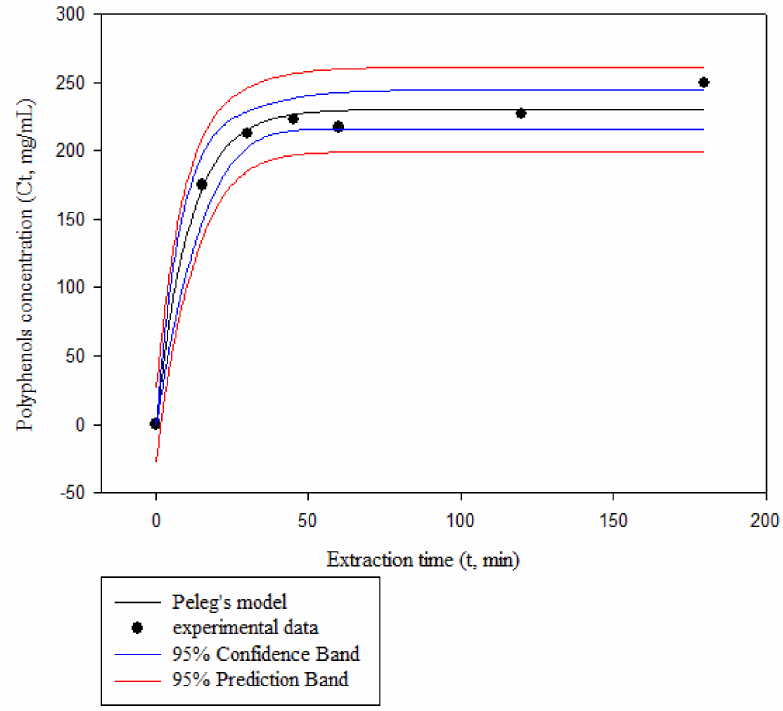
Figure 4. Experimental and predicted by the Peleg’s model values of polyphenols concentration in the extract at an extraction temperature of 60 ◦ C, a CD concentration of 20.5% w/v, and a solid-to-liquid ratio of 1/7.5